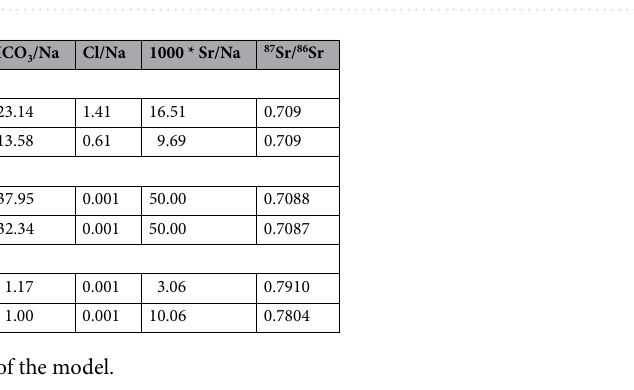
Figure 9. The path model of Sr and its isotopes for various factors during periods of high (left) and low water (right).